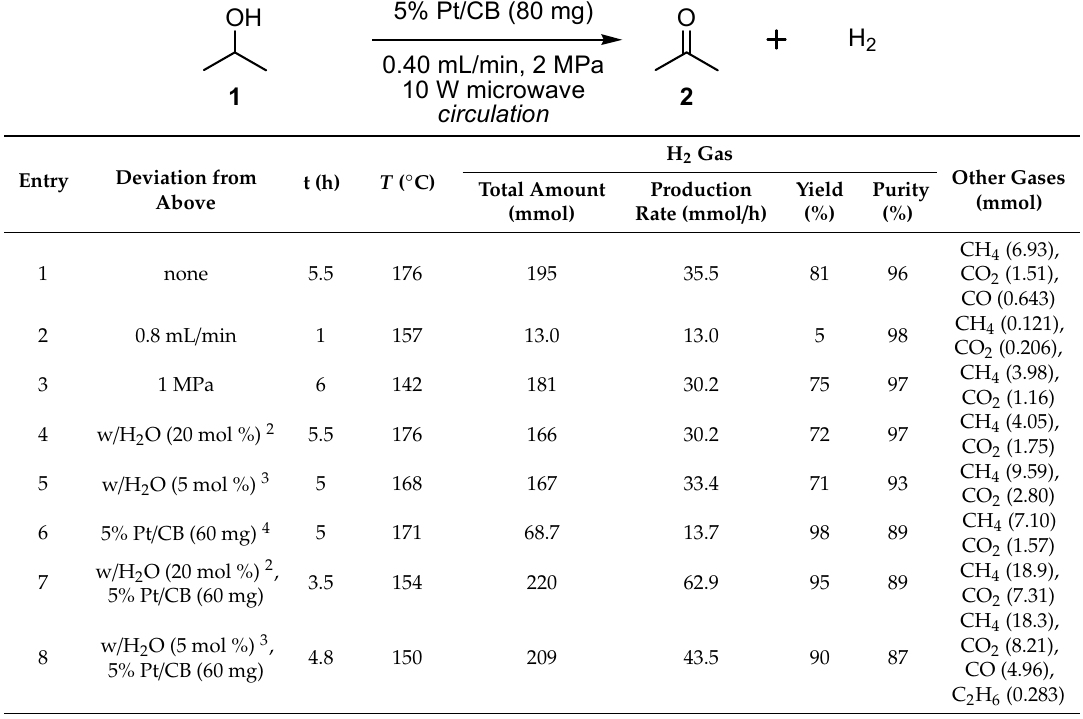
Catalysts 2019 , 9 , x FOR PEER REVIEW 6 of Table 2. E ffi ciency of the reaction parameter 1 .